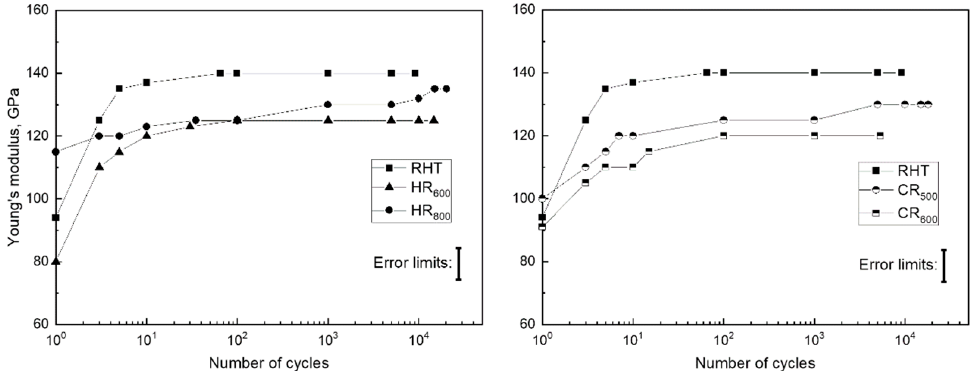
Figure 7. Evolution of Young’s modulus during mechanocycling of the Fe-30Mn-5Si alloy after various treatment regimes.